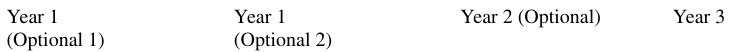
Table 3 Curriculum for a three-year doctoral